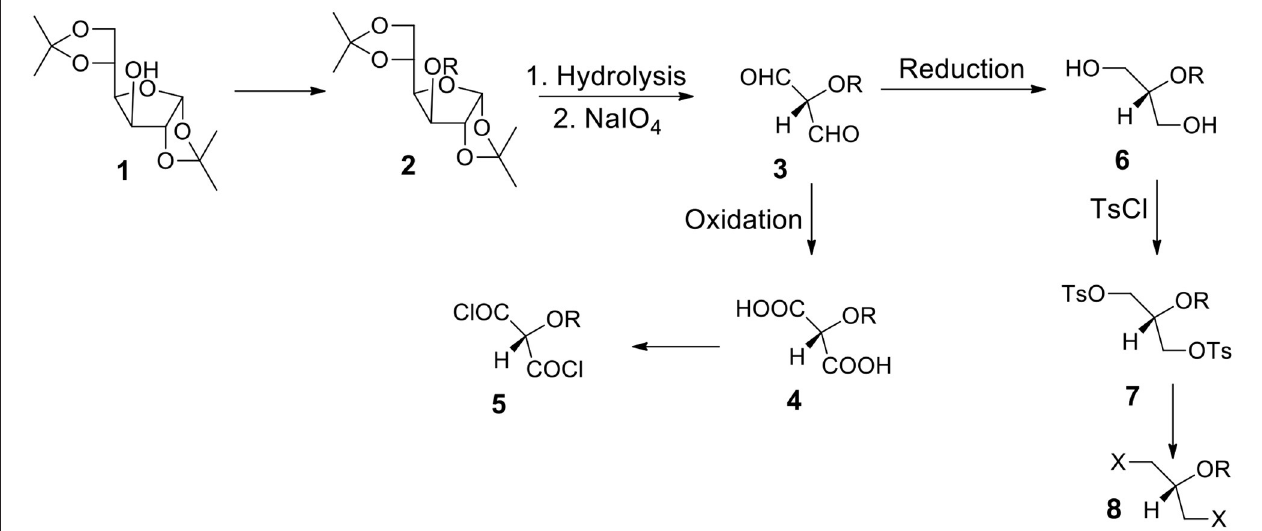
FIGURE 3 | Synthesis of aqueous soluble and aqueous insoluble bifunctional compounds starting from 1,2:5,6-di- O -isopropylidene- α - D -glucofuranose 1 . Hydrolysis and periodate oxidation produce versatile (hydroxy-protected) dialdehyde 3 that can be transformed into hydrophilic or hydrophobic moieties equipped with various reactive groups.